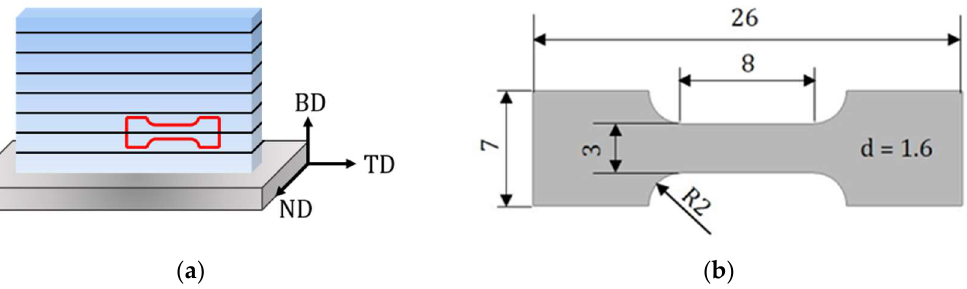
Figure 1. ( a ) Schematic illustration of the sample produced by PBF-LB/M. The superimposed schematic highlights the sample used for the mechanical testing. ( b ) Specimen geometry used for mechanical testing. The loading axis is oriented perpendicular with respect to building direction (BD), as seen in the schematic representation. (TD—transverse direction, ND—normal direction).